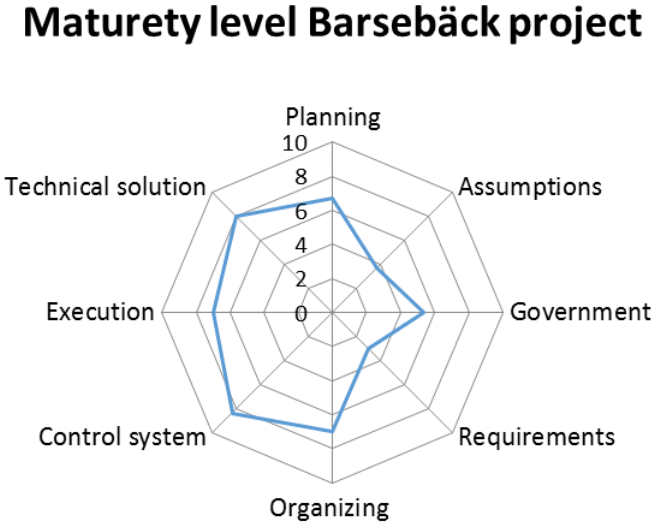
Figure 2. Relative maturity of different aspects of the Barsebäck project at the time of the analysis.